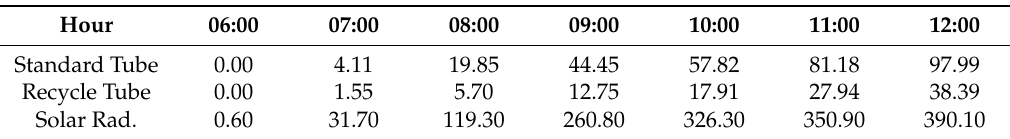
Table 4. Values obtained from the analysis of the luminosity in the test environments and in the meteorological station—Part 1.